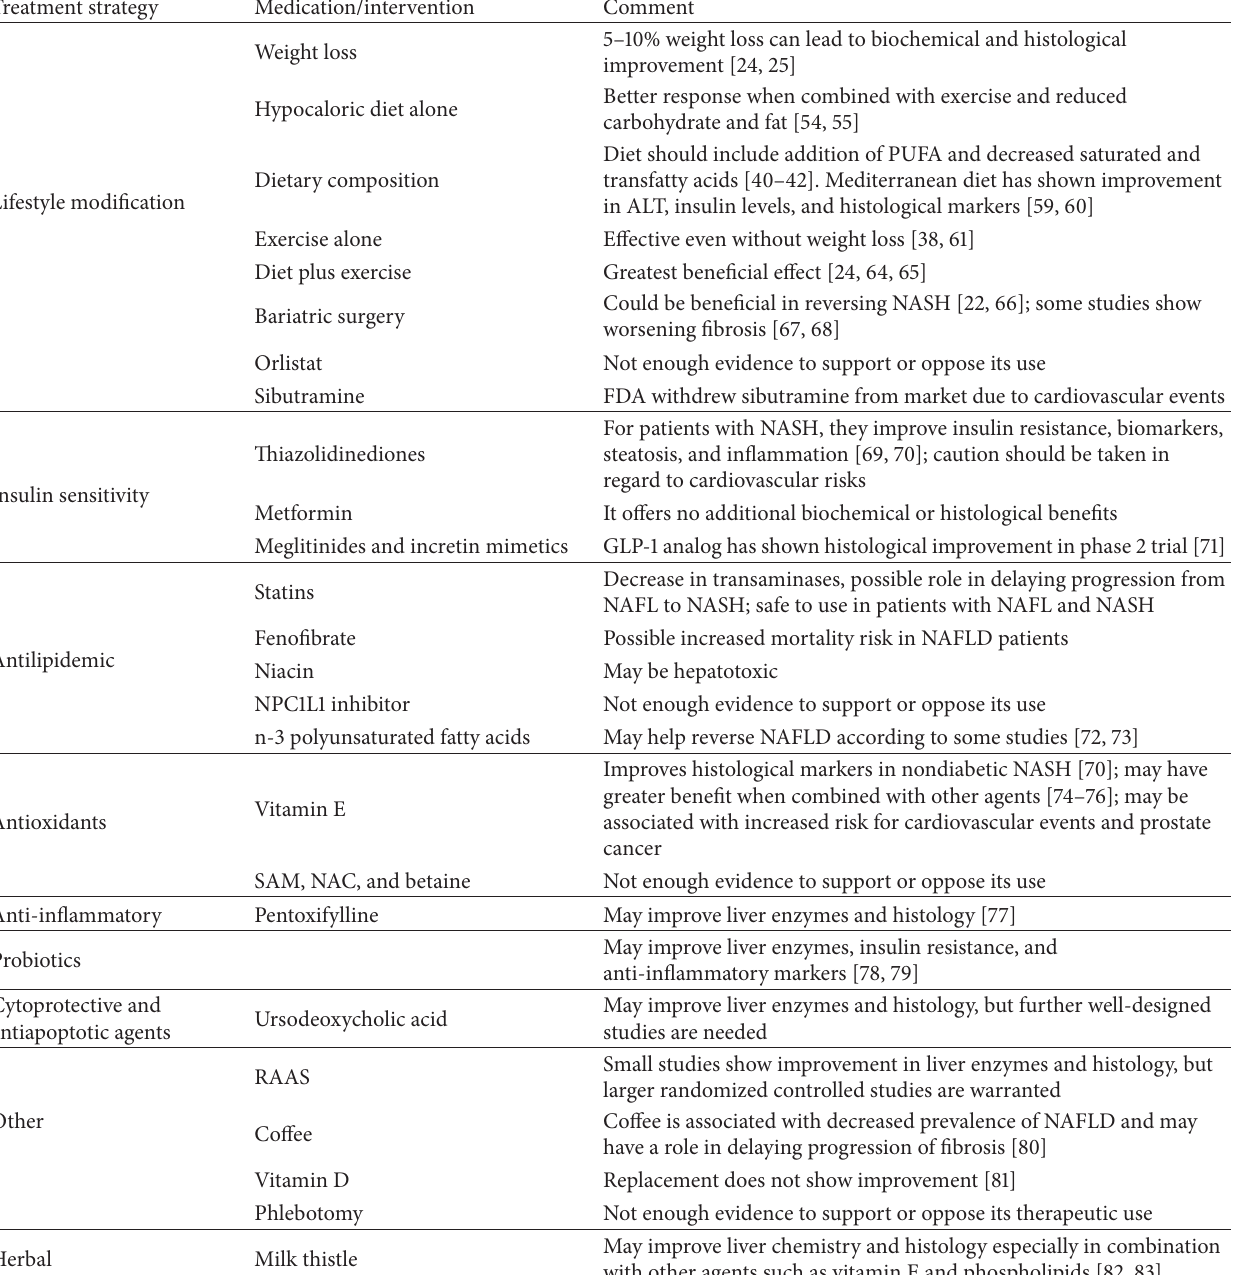
Table 1: Summary of treatment options for